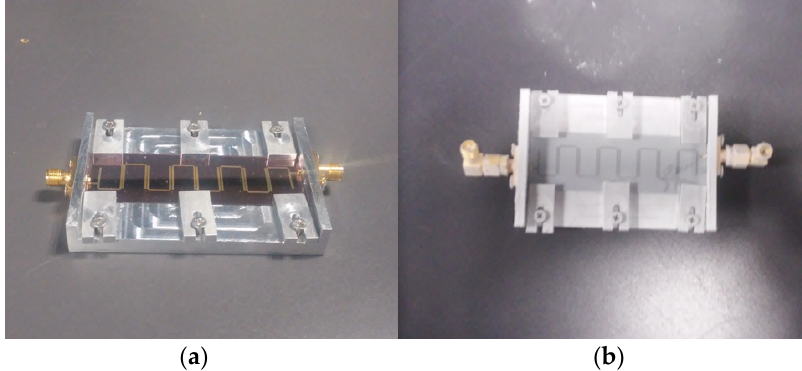
Figure 3. Two packaged filters: ( a ) conventional Cu; ( b ) superconducting YBCO thin film.